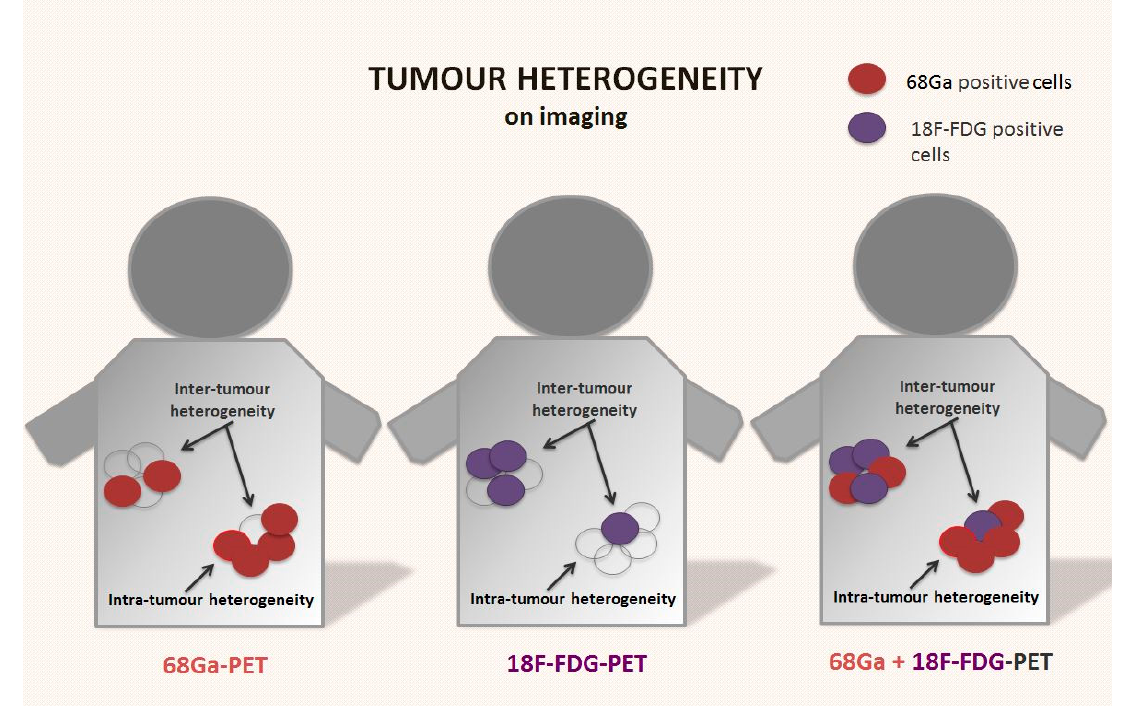
Figure 2. Tumour heterogeneity on receptor-based and functional imaging of NENs. Neuroendocrine neoplasms are usually positive on somatostatin receptor-based imaging (i.e., 68Ga-DOTA-peptides PET). However, the presence of tumour heterogeneity with areas that express lower or no somatostatin receptors is common on baseline scans, and often after disease relapse or progression. These areas are often less differentiated and metabolically active. The use of 18F-FDG-PET, especially in combination with receptor-based imaging, can potentially provide a better picture of metabolic spatial intra- and inter-tumour heterogeneity of the disease, especially in higher-grade tumours.